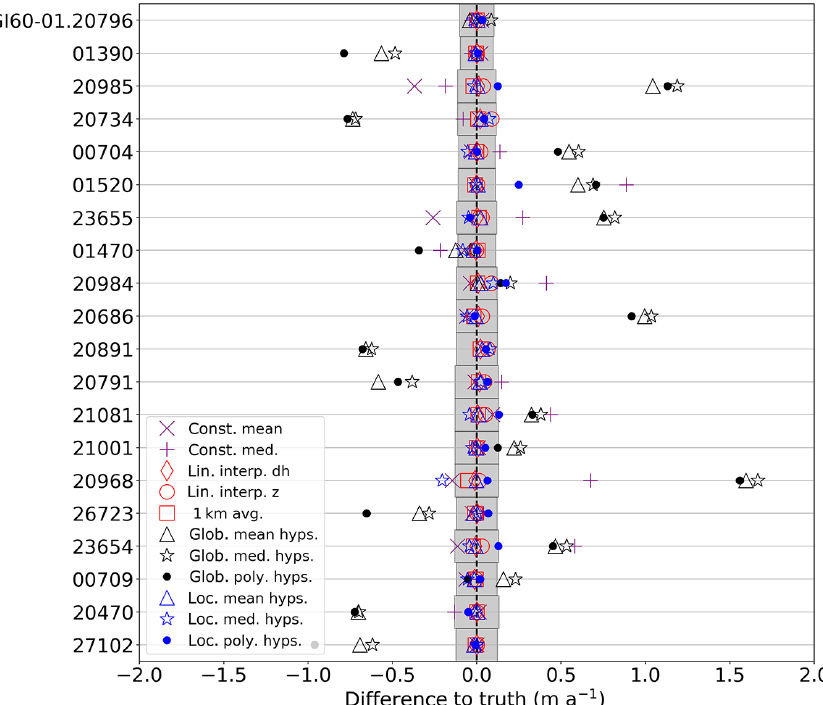
Figure 7. Comparison to true volume change for glaciers larger than 100km 2 , sorted by glacier area in descending order. Gray bars indicate the uncertainty of the true volume change estimate for each